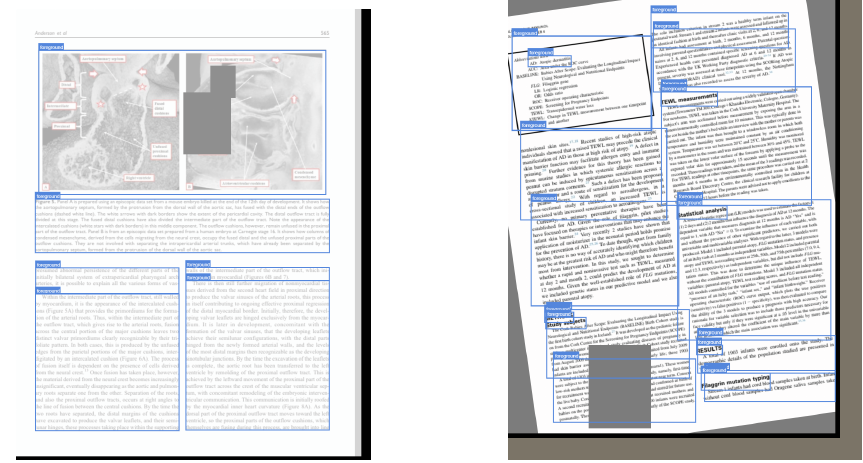
Figure 5. Left : Augmentation with rotation and blur. Right : Augmentation with scale and shift. The images represent the regression pseudo boxes on two different augmented images. They are generated by the Teacher model during the training process of the Soft Teacher model on 10% labeled